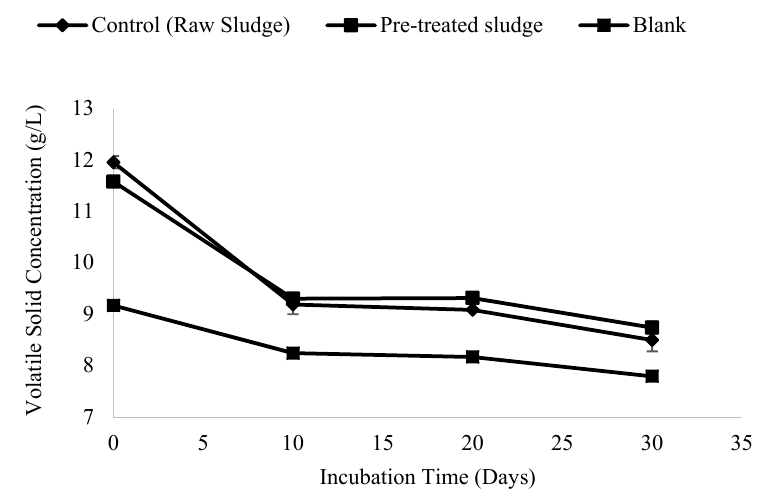
Figure 1. Example of solids reduction measurements during 30-day BMP test.